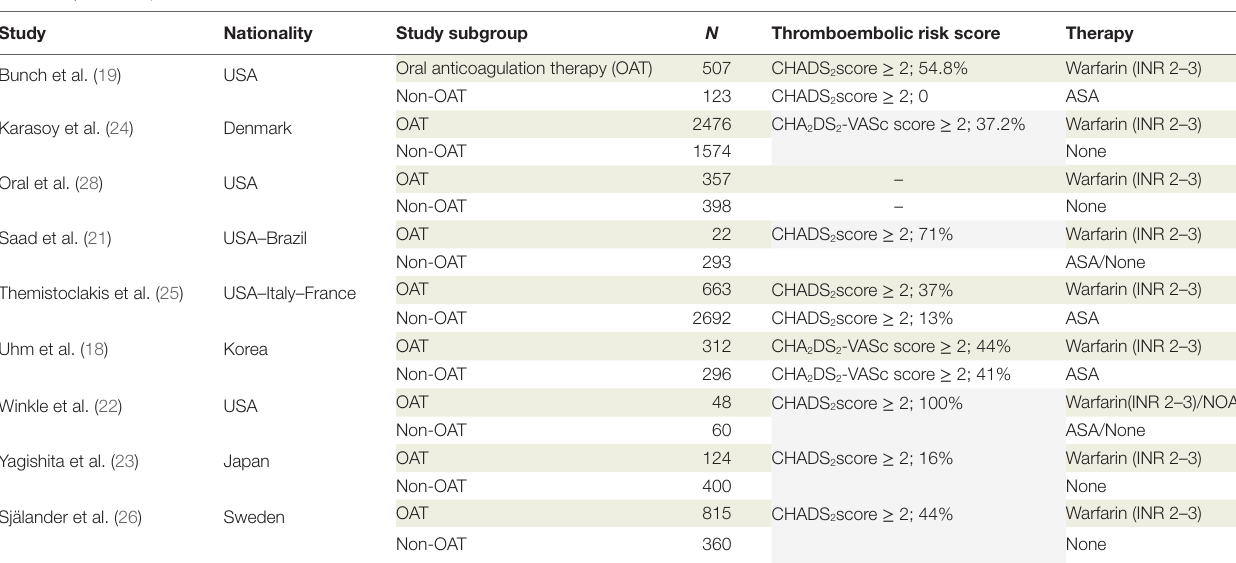
FiGUre 1 | Study selection flow chart. Selection and data abstraction process, performed according to the PRISMA statement. taBLe 1 | Baseline patients’ risk across the